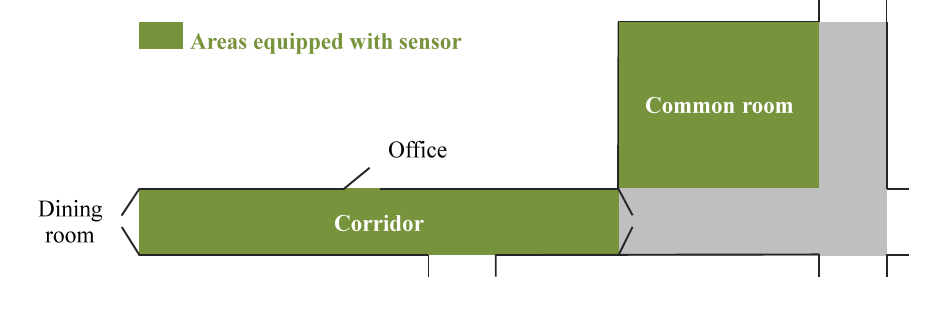
Figure 8. System installation in the nursing home.